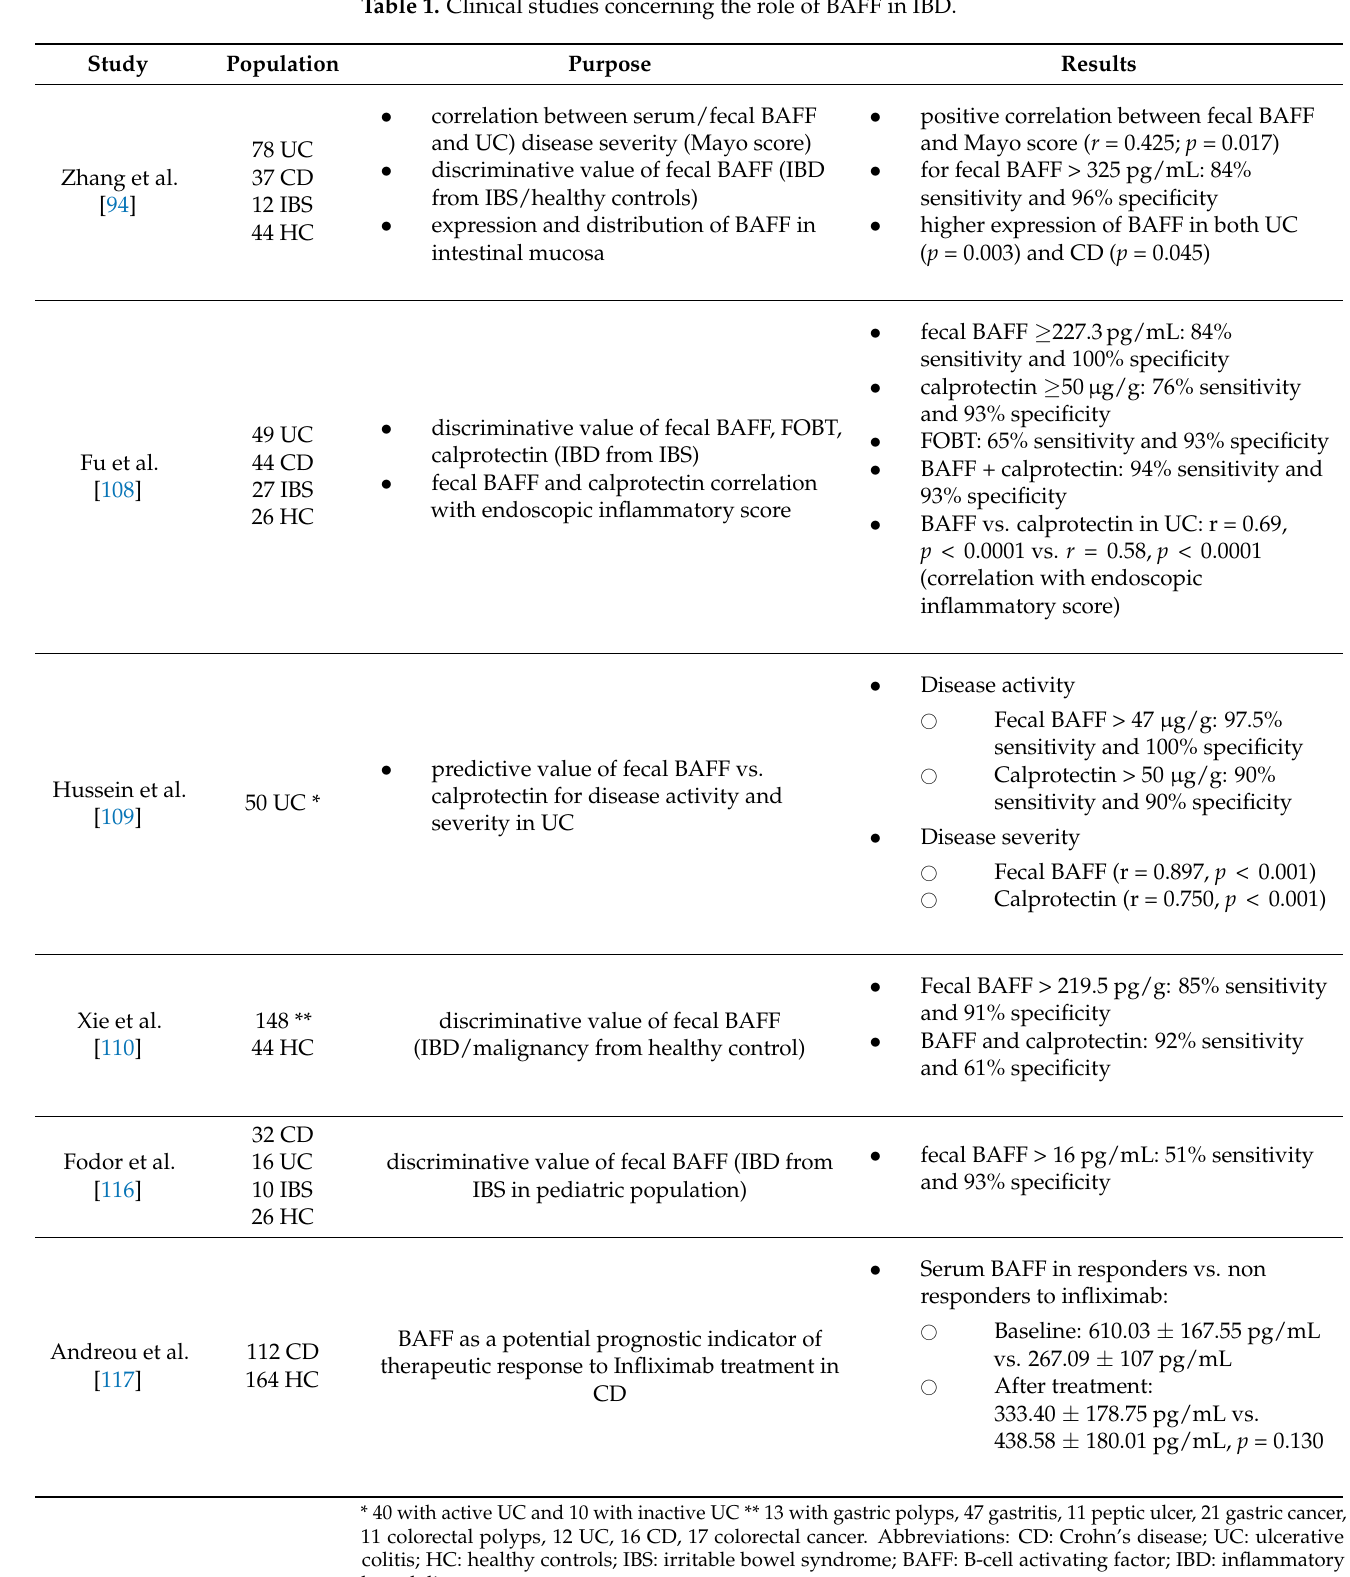
Table 1. Clinical studies concerning the role of BAFF in